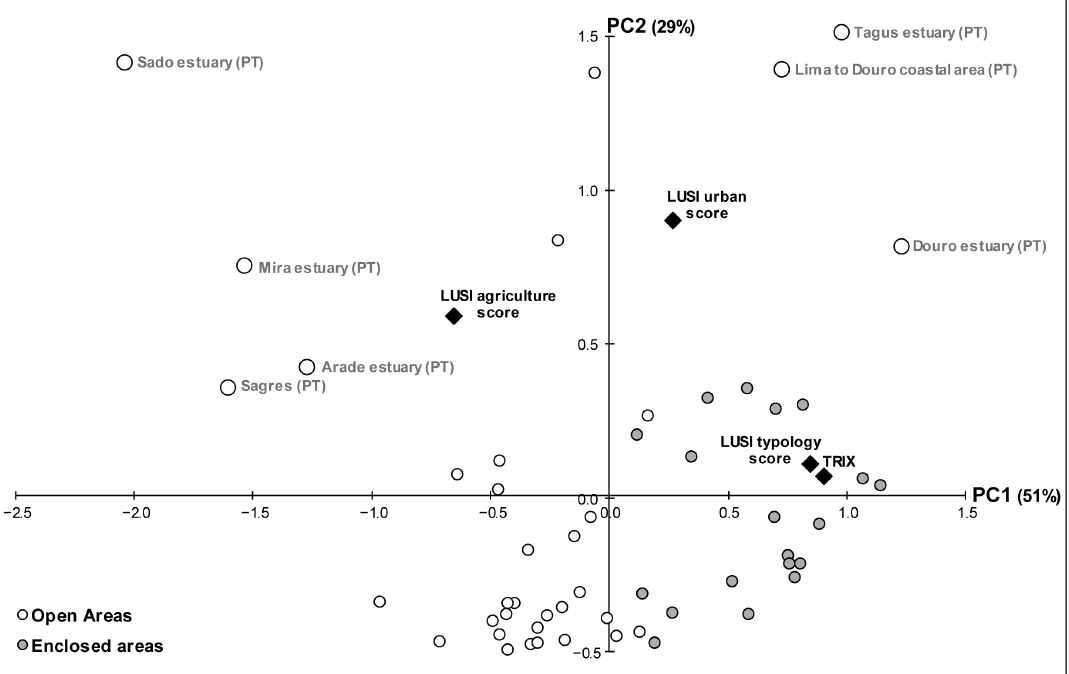
Figure 10. Projection of trophic state of coastal waters (TRIX index) and LUSI Utilized Agricultural Area, Urban, and Typology score values, and assessed water bodies, obtained from Principal Component Analysis (PCA). Percentage of total variance is indicated in brackets close to principal component axes. Please note that all labels for the estuary refer to coastal sampling stations located in front of the estuarine mouths.